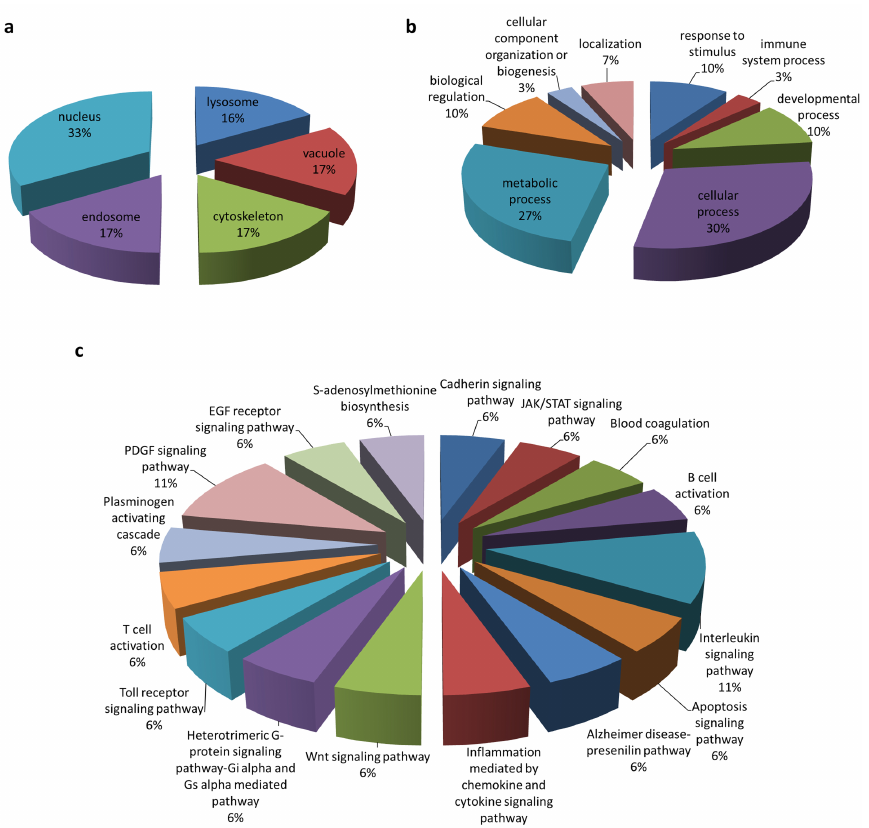
Figure 2. Gene annotation of the ORF3 interactome. Classification was based on ( a ) organelle compartment, ( b ) biological process, and ( c ) pathway by PANTHER